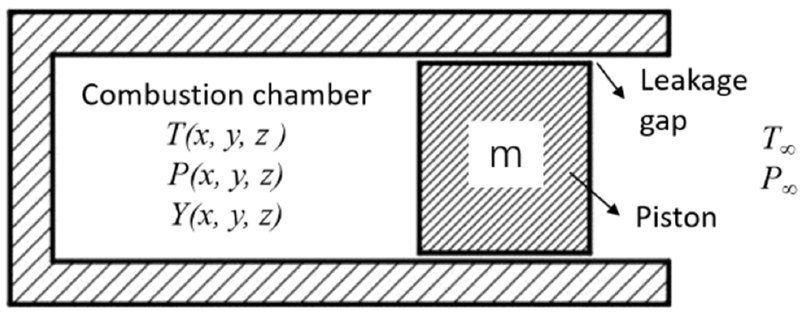
Figure 1. Physical model of micro-HCCI free-piston engine.